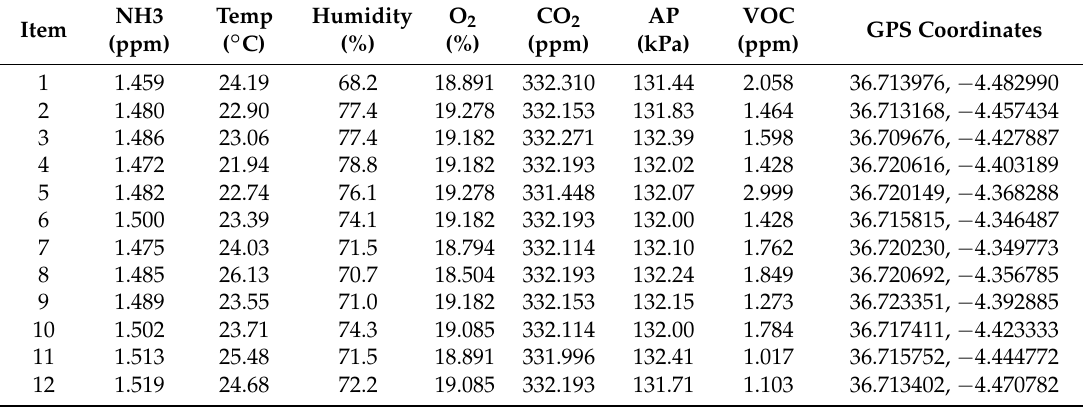
Table 2. Summary of the data obtained by the Mobile node in a route in the city of M á laga, working in networked